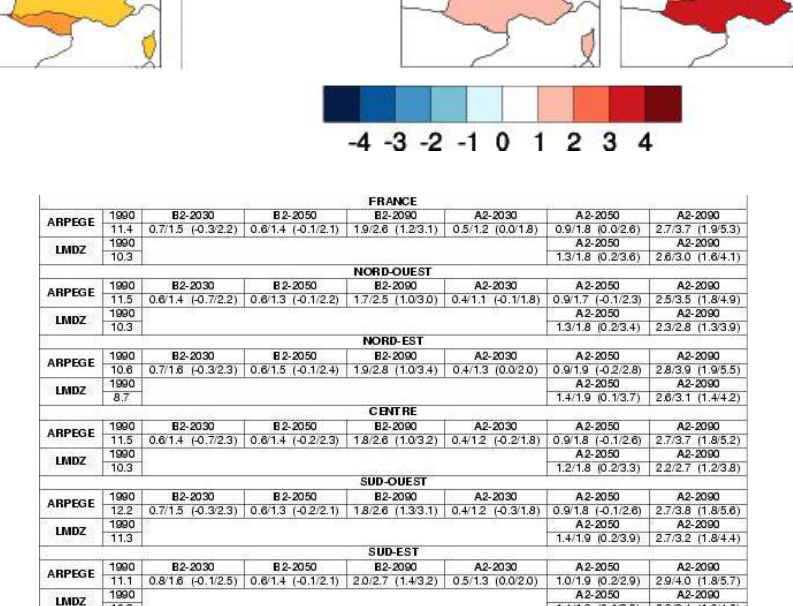
Figure 2. Example of typical climate product that could be available on DRIAS web portal. In this case, mean daily temperature in annual average is represented (Unit: ◦ C) for the reference period and deviations between projections and reference. Simulations from two models (ARPEGE and LMDZ) are shown. Interval of uncertainty for mean value and extreme value (in brackets) are computed for 5 major French regions. From a 2011 report given to the Ministry, written by the partners of the DRIAS project (available on the website: http: // www.developpement-durable.gouv.fr / Les-scenarios-climatiques-de.html).